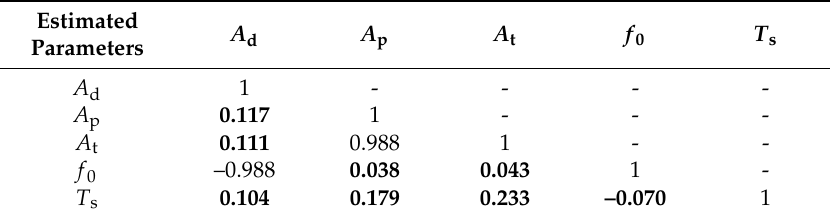
Table 3. Correlation matrix for the estimated parameters of the